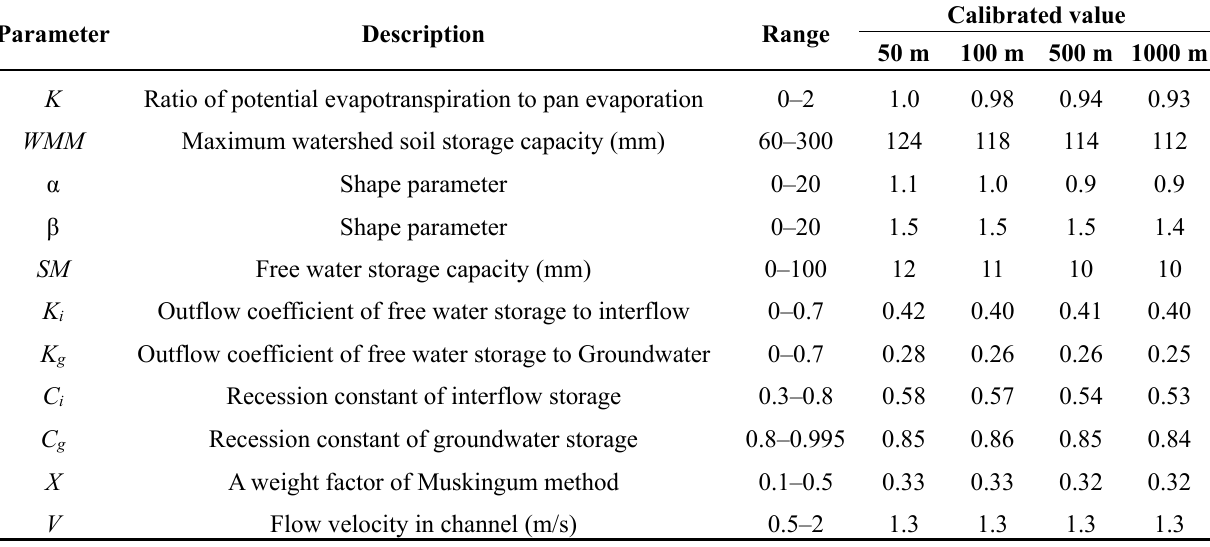
Table 2. Model parameters and calibrated values at 4 different grid